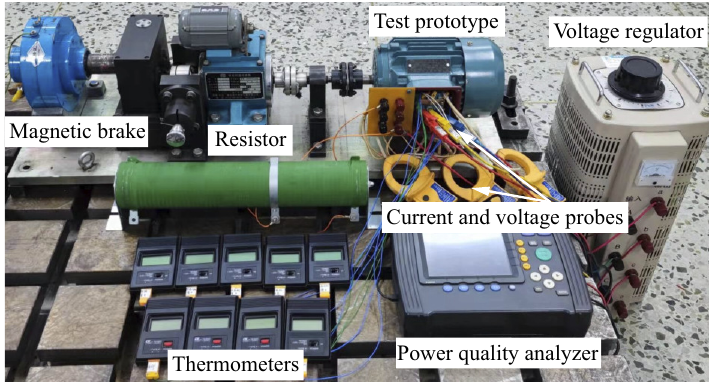
Figure 4. Motor TR experimental platform.